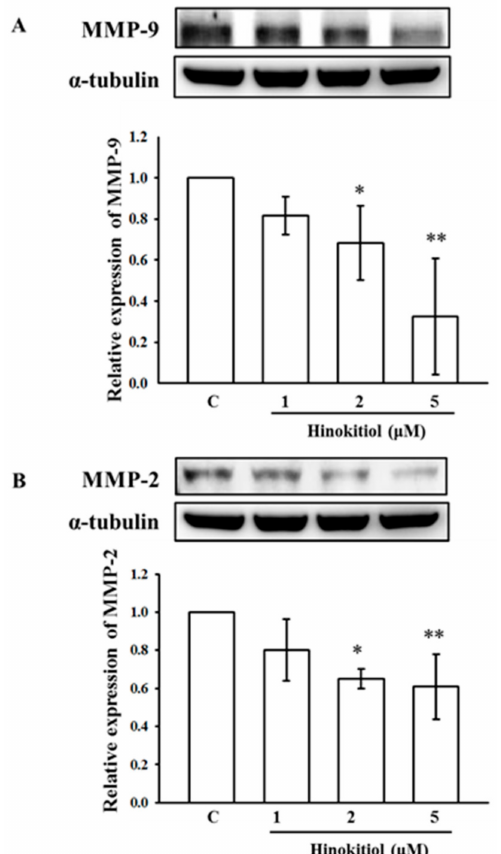
Figure 4. Effects of hinokitiol on matrix metalloproteinases (MMP)-9 and MMP-2 expression in A549 cell line. A549 cells were treated with different concentrations of hinokitiol (1–5 µ M) in serum-free media for 24 h. After the treatment periods, cell lysates were collected to detect the expression of MMP-9 ( A ) and MMP-2 ( B ) by using Western blotting. The figures are representative examples of three independent experiments. * p < 0.05 and ** p < 0.01 compared with untreated A549